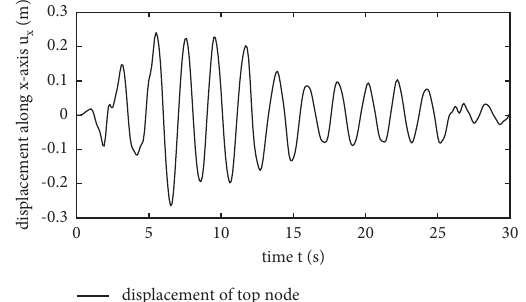
Figure 6: Displacement of top node (o) along the (x)-axis.